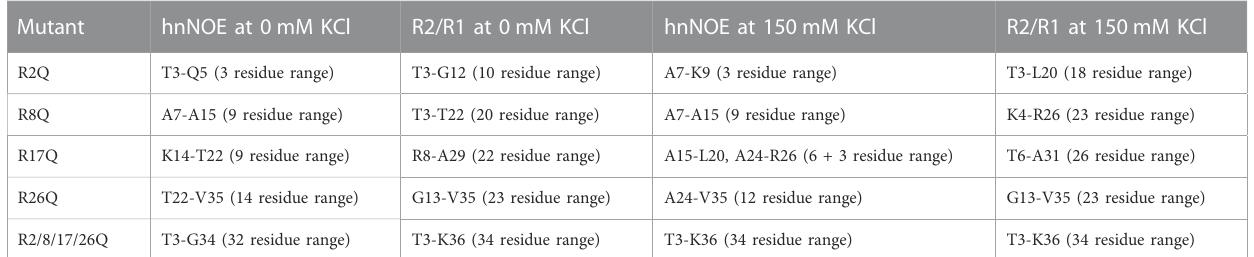
TABLE 1 Compilationof the breadth of the effect of arginine mutations on H3 tail dynamicswithin mutant-H3-NCP as compared to WT-H3-NCP.The H3 tail region affectedbyarginineneutralizationwasde fi nedbyastringofatleastthreeresidueswithnon-overlappingerrorbars(withpossibleinterruptionbysingleresidues with overlapping error bars). The range was determined for each mutant from either hnNOE or R2/R1 data sets at 0 or 150 mM KCl. The boundaries of the region arelistedalongwiththenumberofresidueswithinthisrangeforquickassessmentoftheeffect.SeehnNOEandR2/R1dataplottedinFigures3,5;Supplementary Figures S5, S7.